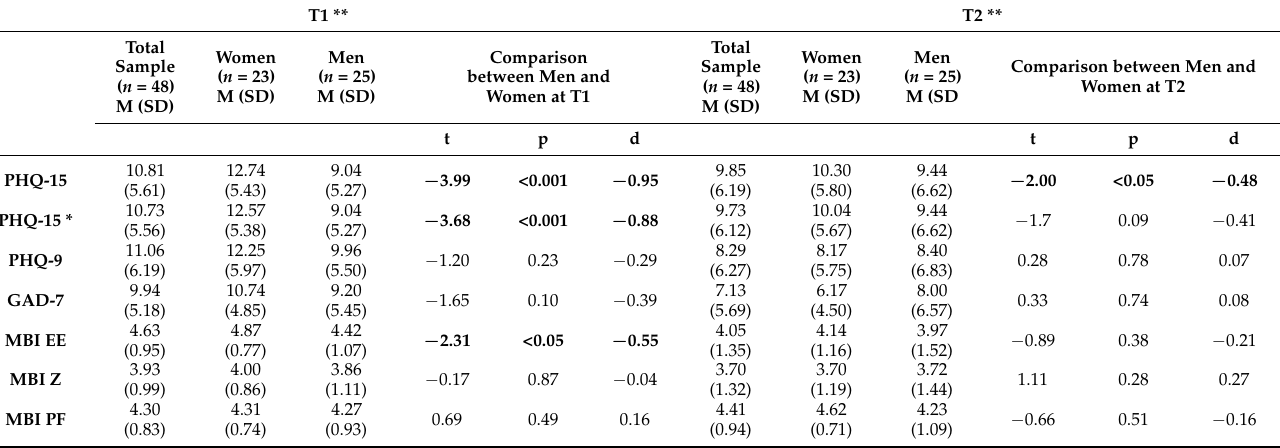
Table 3. Symptoms at admission and